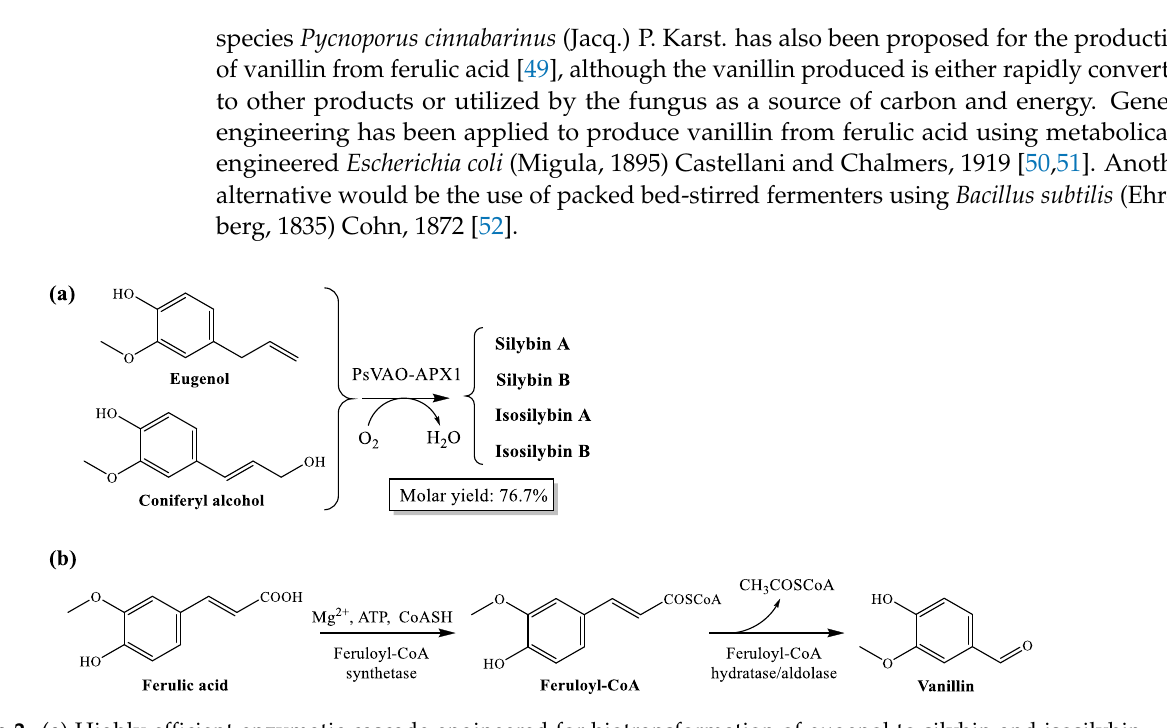
Figure 2. ( a ) Highly efficient enzymatic cascade engineered for biotransformation of eugenol to silybin and isosilybin. Adapted from [44]. ( b ) Schematic representation of the non- β -oxidative pathway for conversion of ferulic acid into vanillin, according to [51] .